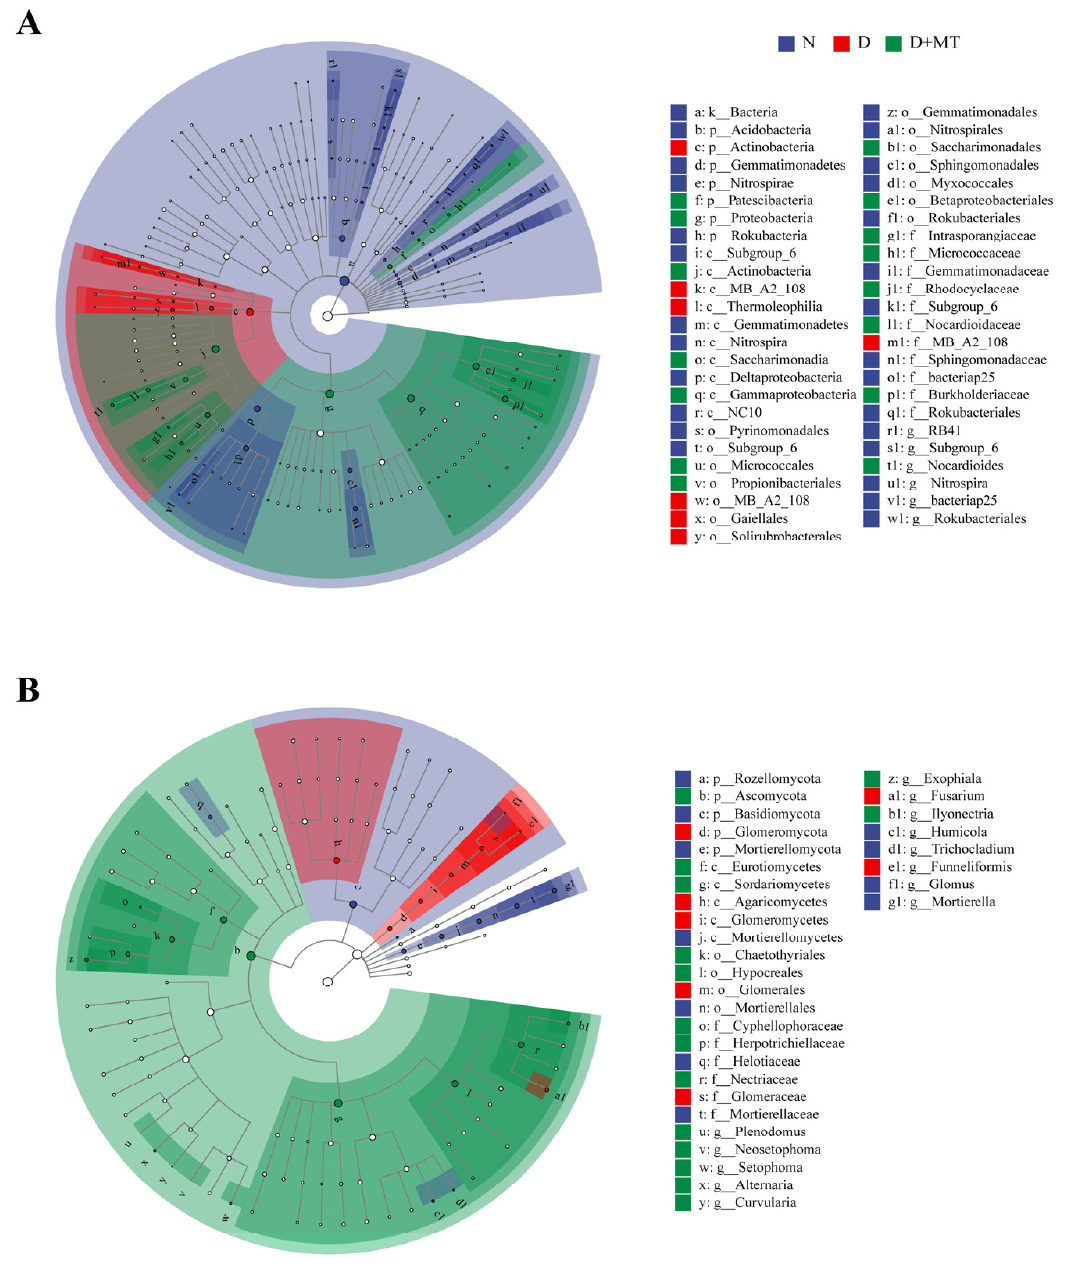
Figure 6. Linear discriminant analysis effect size (LEfSe) of the bacterial ( A ) and fungal ( B ) taxa with an LDA score > 3.5 under the combination of melatonin treatment and drought stress. Cladograms indicate the phylogenetic distribution of microbial lineages. Circles represent phylogenetic levels from kingdom to genus. N, normal control; D, drought stress; D + MT, melatonin + drought